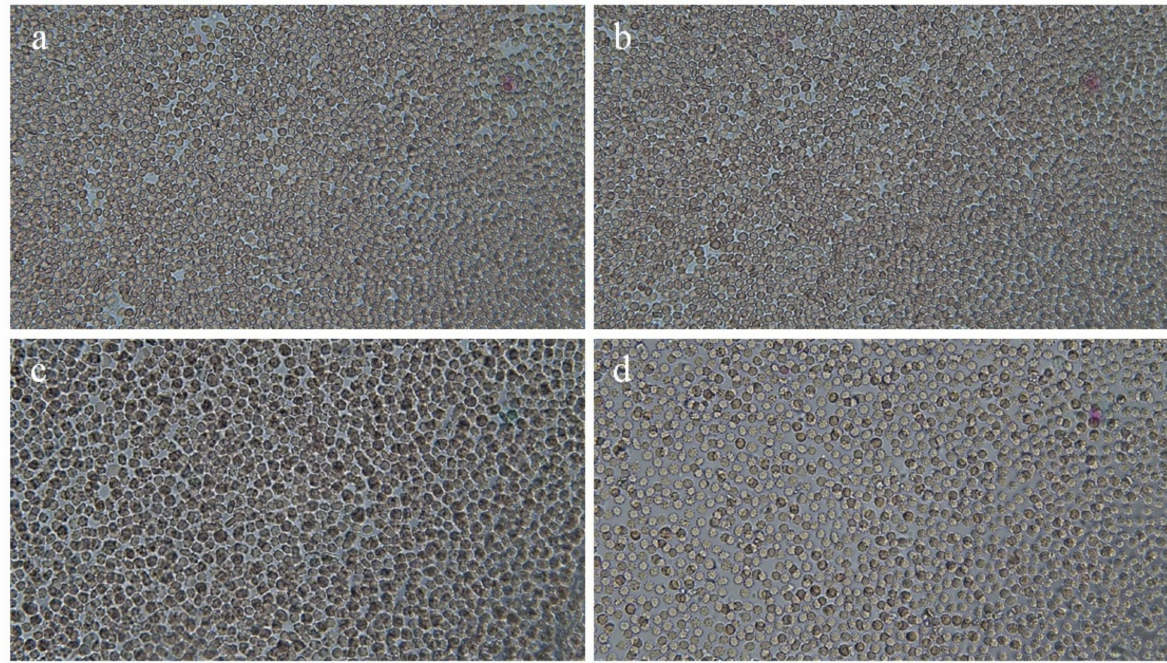
Figure 12. Human blood specimen exposed to hydrogels, ( a ) Control ( b ) Blood after incubation without hydrogel contact, ( c ) Blood in contact with blank gels (AG-1), ( d ) Blood in contact with DSP-loaded gels (AG-1). Photos were taken by using Trinocular (Accu-Scope 3001) microscope equipped with 5-megapixel camera at 40 ×